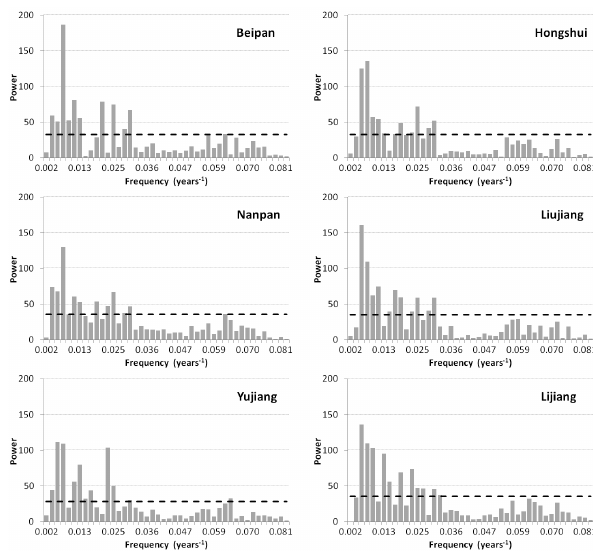
Fig. 10. Spectral analysis of the SPI-24 of the six sub-basins in the Xijiang River basin; the dashed line corresponds to the 90% confi- dence interval of significant periods.